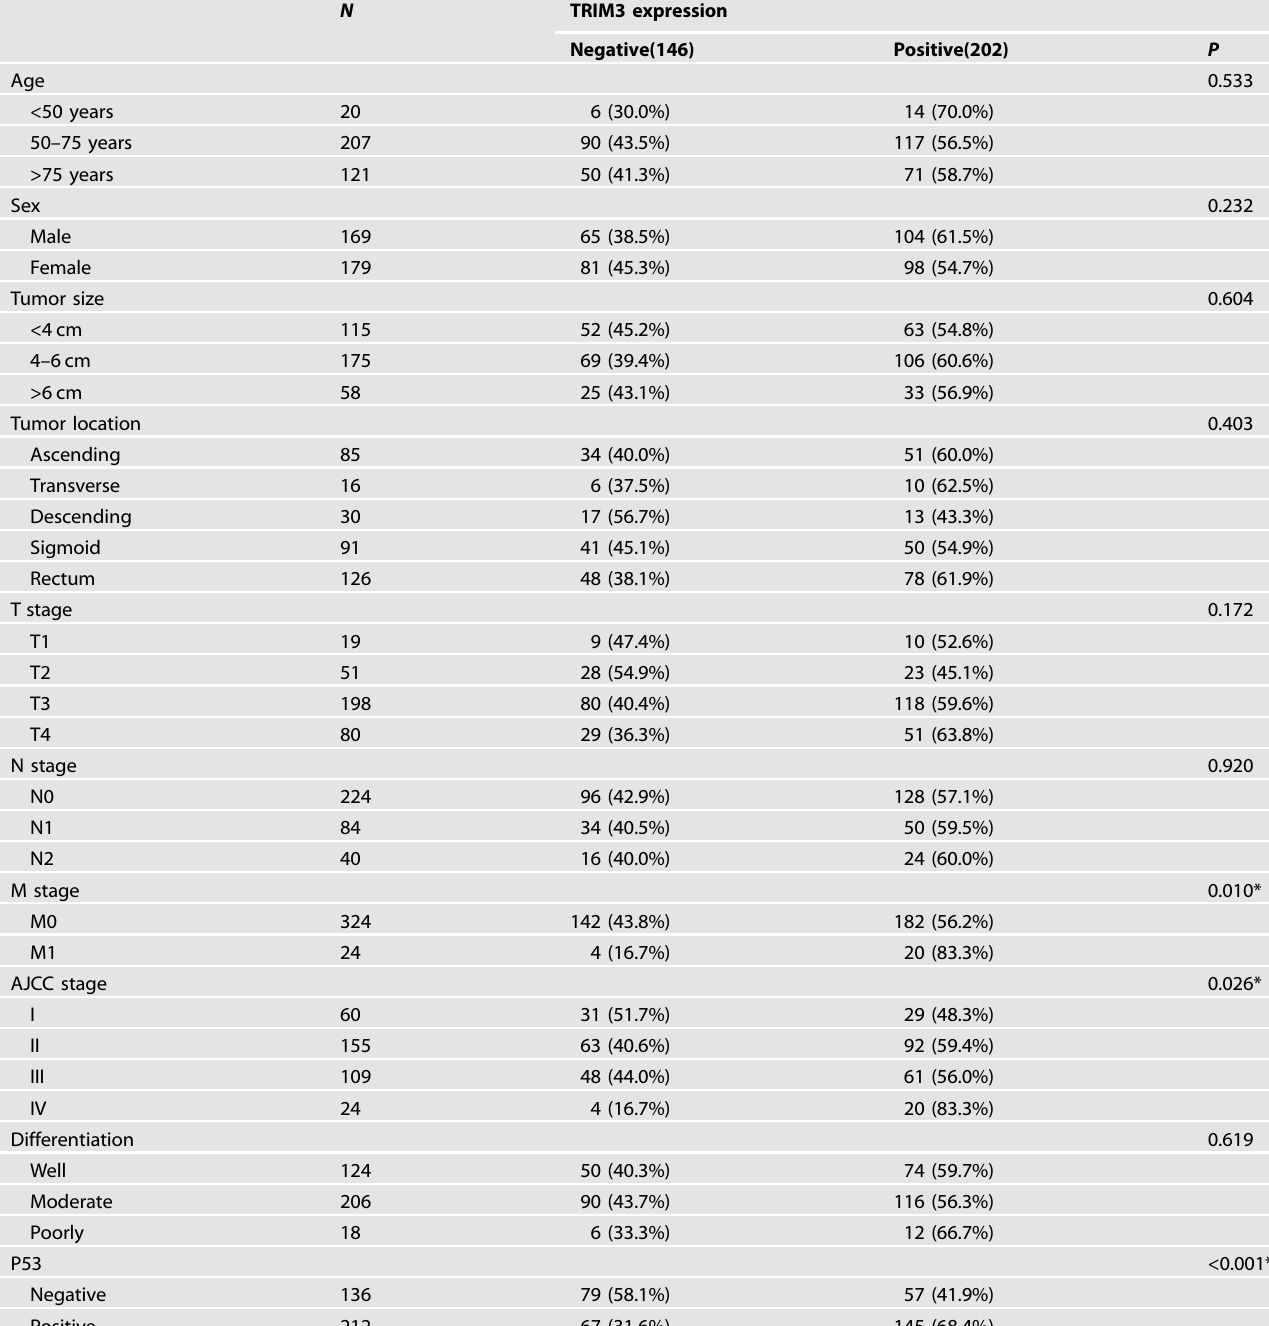
Table 2. Correlation between clinicopathological features and TRIM3 expression ( N =